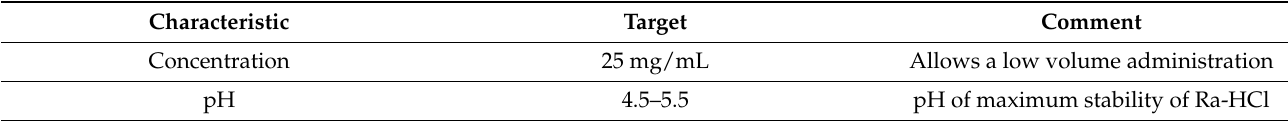
Table 3. Target Product Profile (TPP) established for the oral pediatric solution of ranitidine.